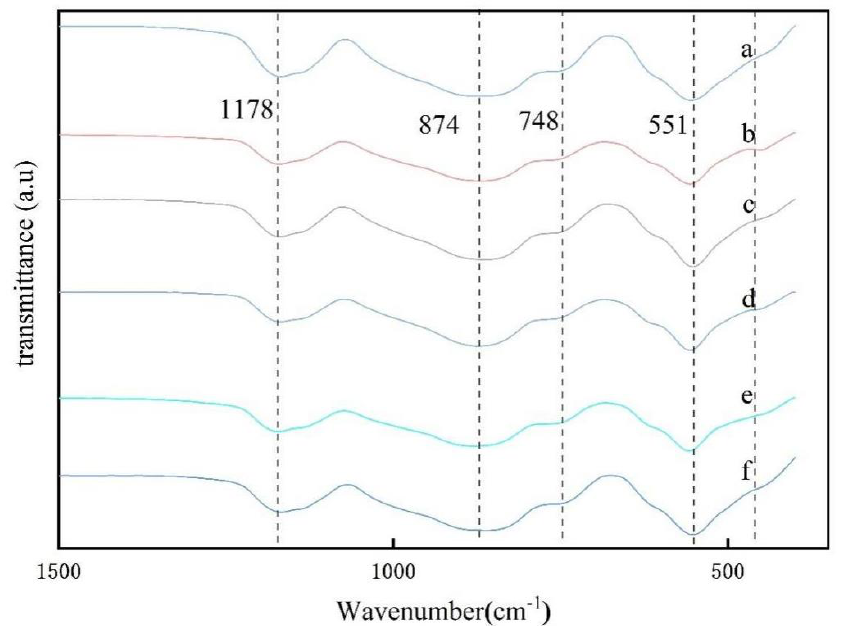
Figure 15. FTIR patterns of mullite whiskers with different aluminum fluoride contents in 10% sodium sulfate molten salt calcined at 825 °C for 3 h for (a) 0.5% AlF 3 ·3H 2 O, (b) 1% AlF 3 ·3H 2 O, (c) 2% AlF 3 ·3H 2 O, (d) 3% AlF 3 ·3H 2 O, (e) 5% AlF 3 ·3H 2 O, (f) 7% AlF 3 ·3H 2 O.